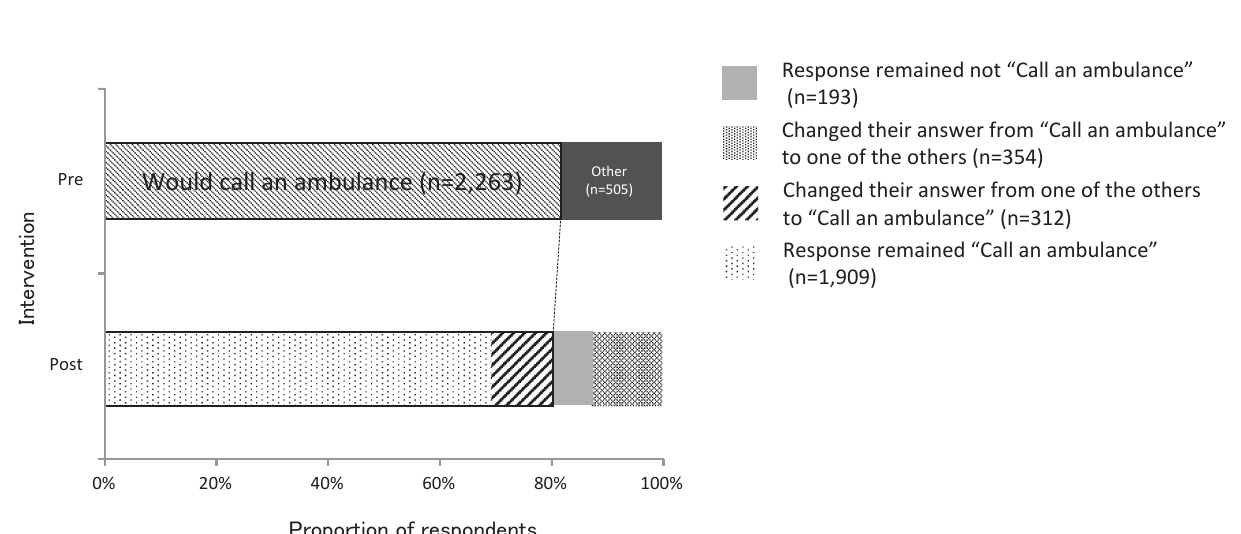
The data were analyzed using the McNemar ’ s test, and are shown as number (%). Would call; those who chose “ call an ambulance ” at the stroke onset, would not call; those who did not choose it.